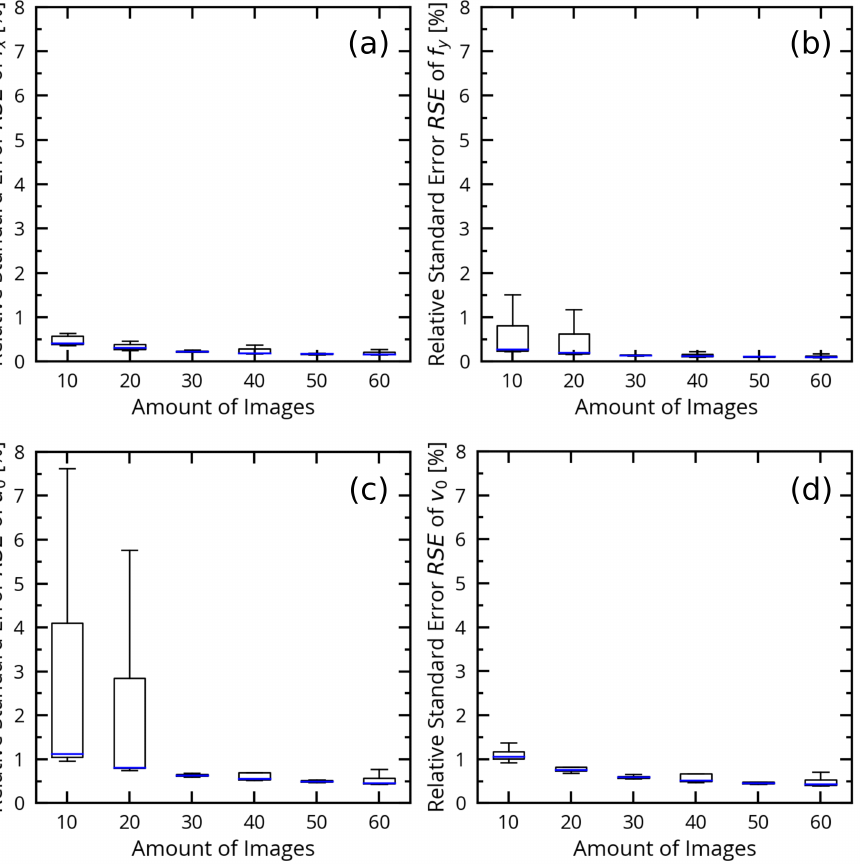
Figure 5. Statistical deviation of the relative standard error ( RSE ) of f x , f y , u 0 and v 0 with respect to the number of images in the calibration dataset (f = 25 mm) after 20 rounds. ( a ) RSE for f x shows consistent results below 1% for 10 to 60 calibration images. ( b ) RSE for f y shows varying results between 1.6% and 0.2% for 10 calibration images and 1.2% to 0.17% for 20 calibration images. For 30 images and more the RSE shows consistent results below 0.40%. ( c ) RSE for u 0 shows varying results between 7.6% and 1% for 10 calibration images and 5.8% to 0.8% for 20 calibration images. For 30 images and more the RSE shows more consistent results below 0.7%. ( d ) RSE for v 0 shows varying results between 1.4% and 1% for 10 calibration images. For 30 images and more the RSE is below 0.7%. For this dataset, 30 random selected images are used to achieve a low and consistent RSE for camera parameter